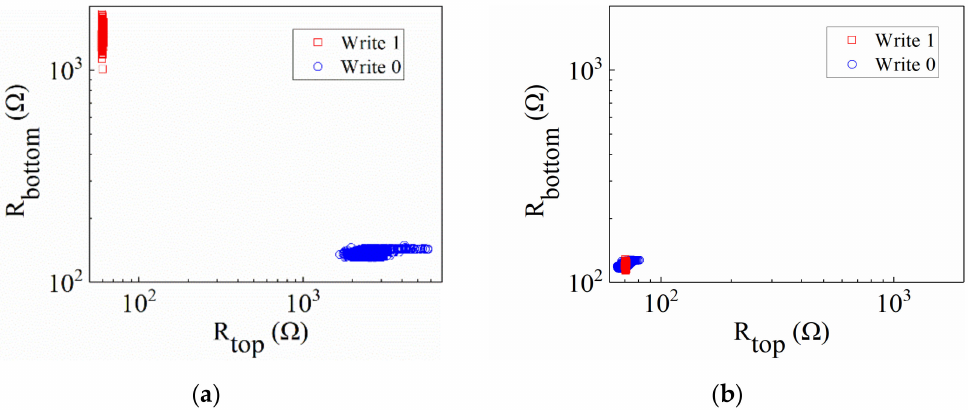
Figure 14. Resistance values of the RRAMs derived from the read operations during the sequence of 1000 unmasking-read- masking-read operations: ( a ) after unmasking; ( b ) after masking.